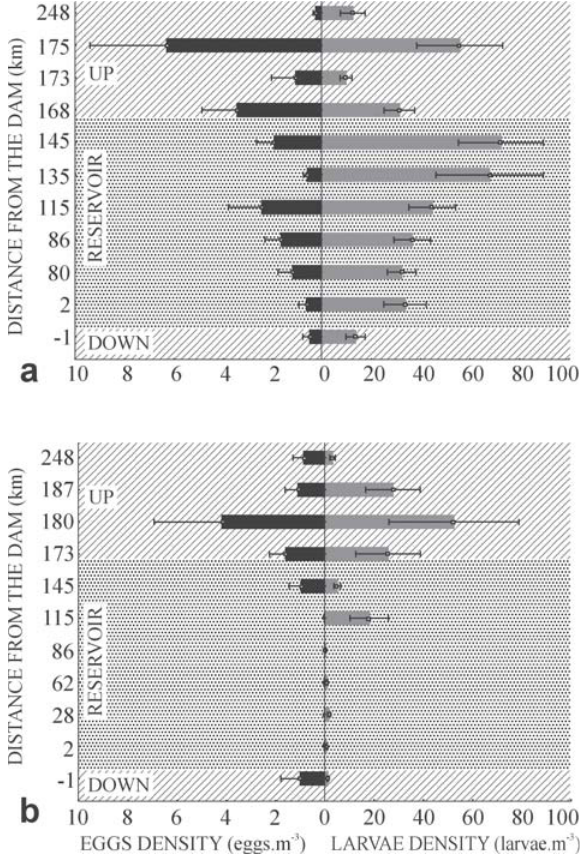
Fig. 2. Spatial variations in the density (± standard deviation - SD) of planktonic fish eggs and larvae in the Middle Tocantins River, before (October, 1999 – September, 2001 - a) and after (October, 2002 – September, 2004 - b) the formation of Lajeado Reservoir (UHE Luís Eduardo Magalhães).